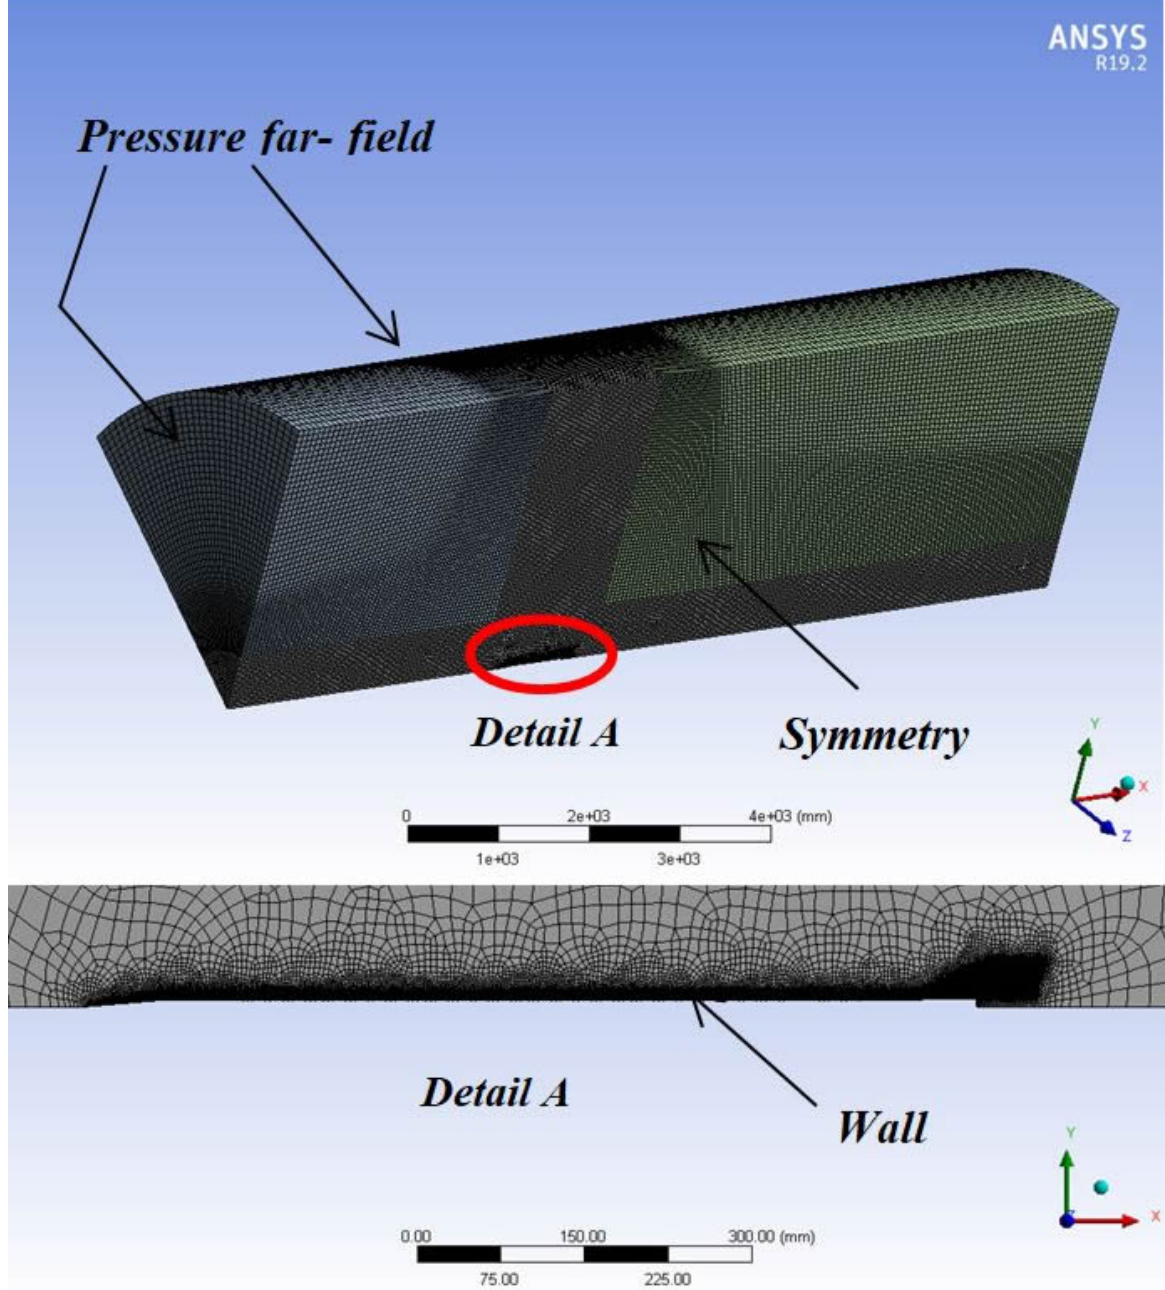
Figure 13. Generated mesh around projectile 120 mm, M829A2, and boundary conditions applied